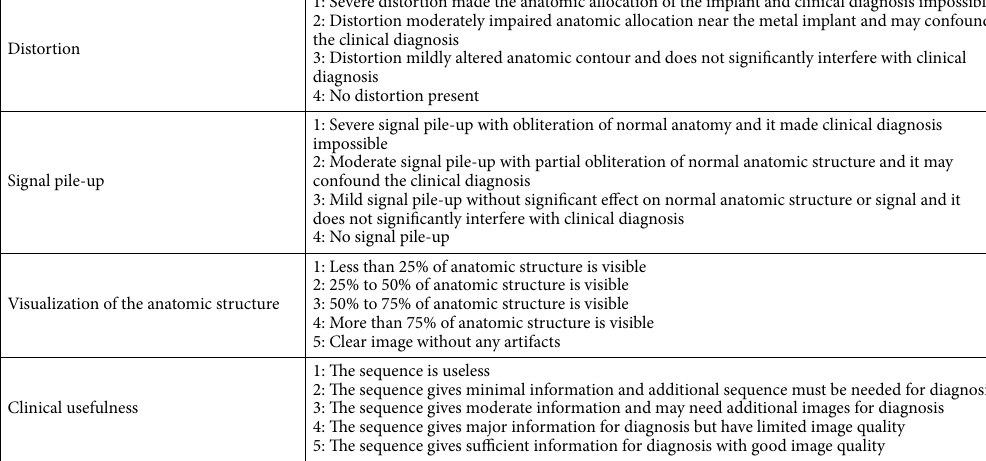
Table 5. Scoring system according to each category of the qualitative analysis of the volunteer study.